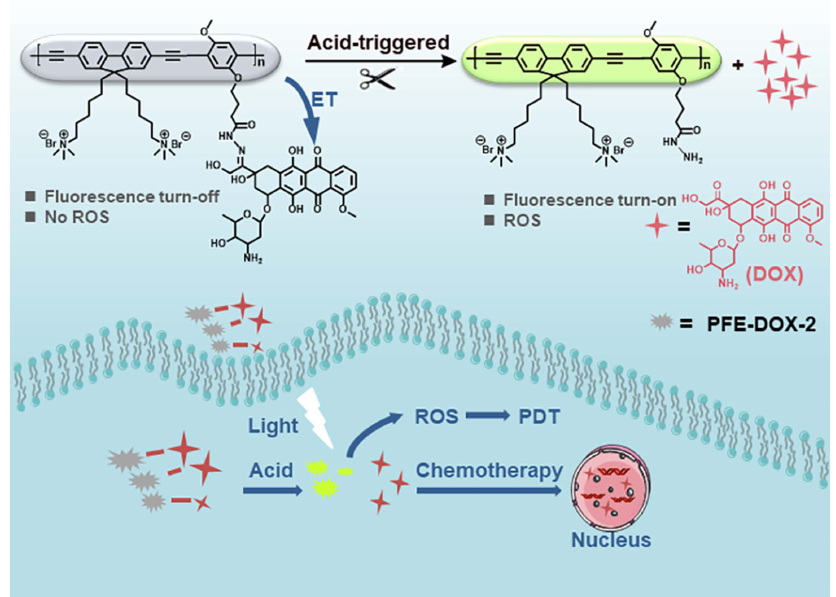
Scheme 1. Schematic diagram of pH-responsive drug release and the mechanism of synergistic chemo-/PDT antitumor